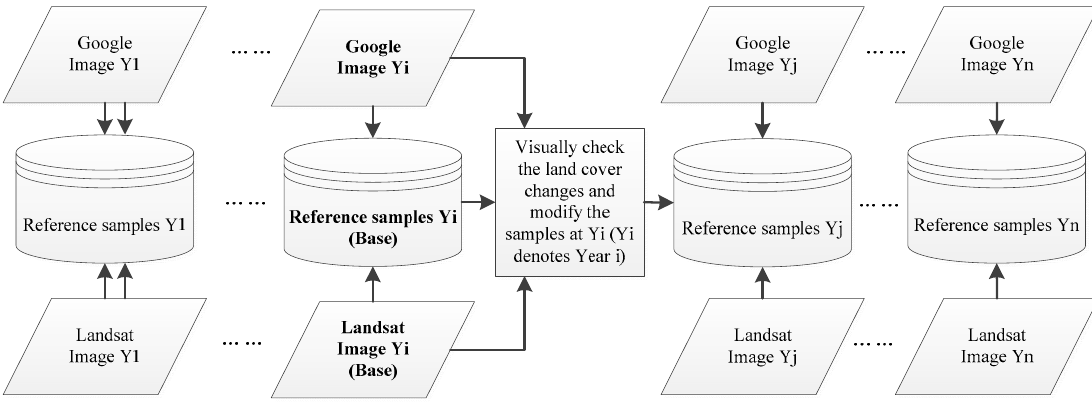
Figure 2. Sampling strategies for collecting the reference samples from high resolution Google Earth images.